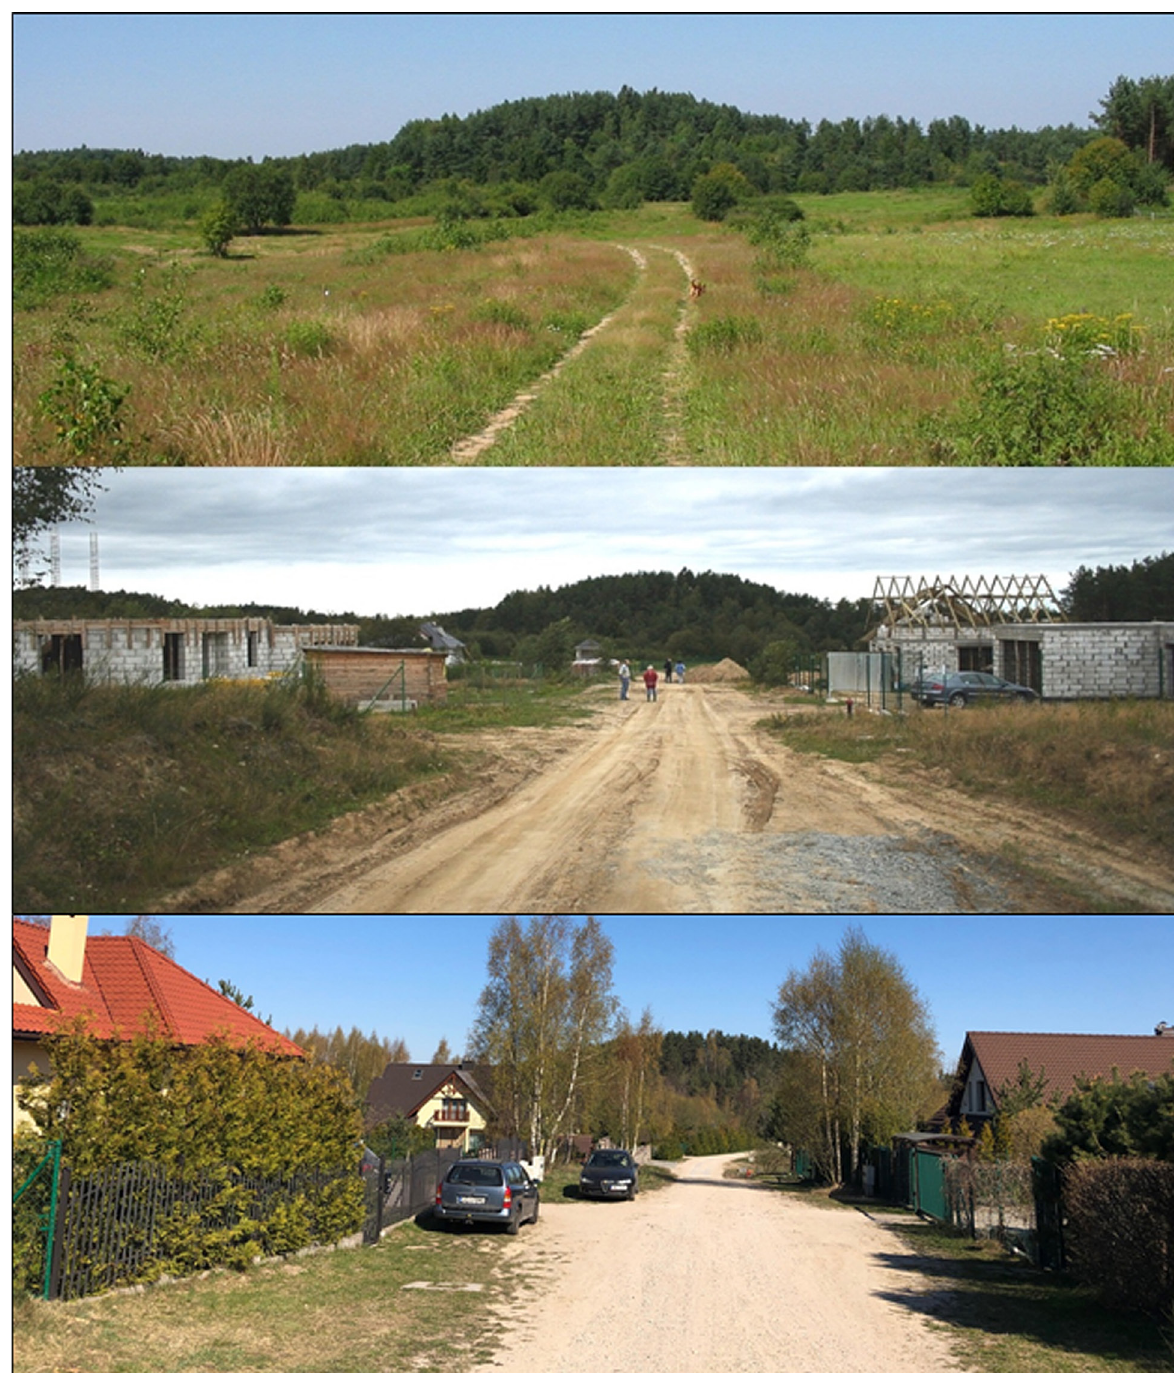
Fig. 6. Change of grasslands into detached houses near Kielno (testing ground B) in 2004, 2007 and 2019. Source: photos taken by P.